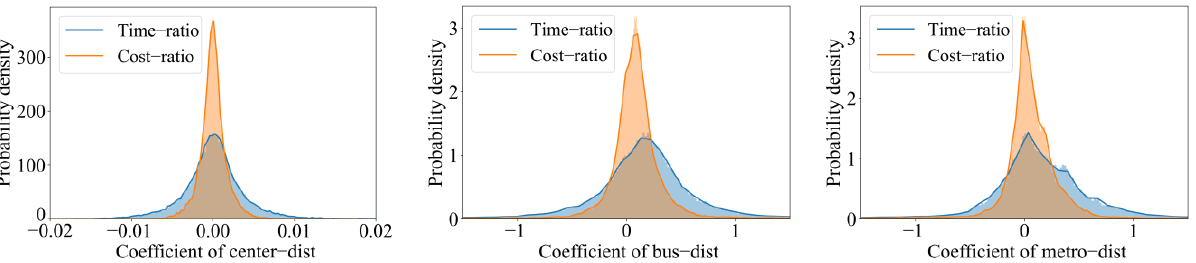
Figure 8. Probability density distribution of the correlation coefficient of each explanatory variable. Table 4. The percentage of positive and negative effects of each explanatory variable.